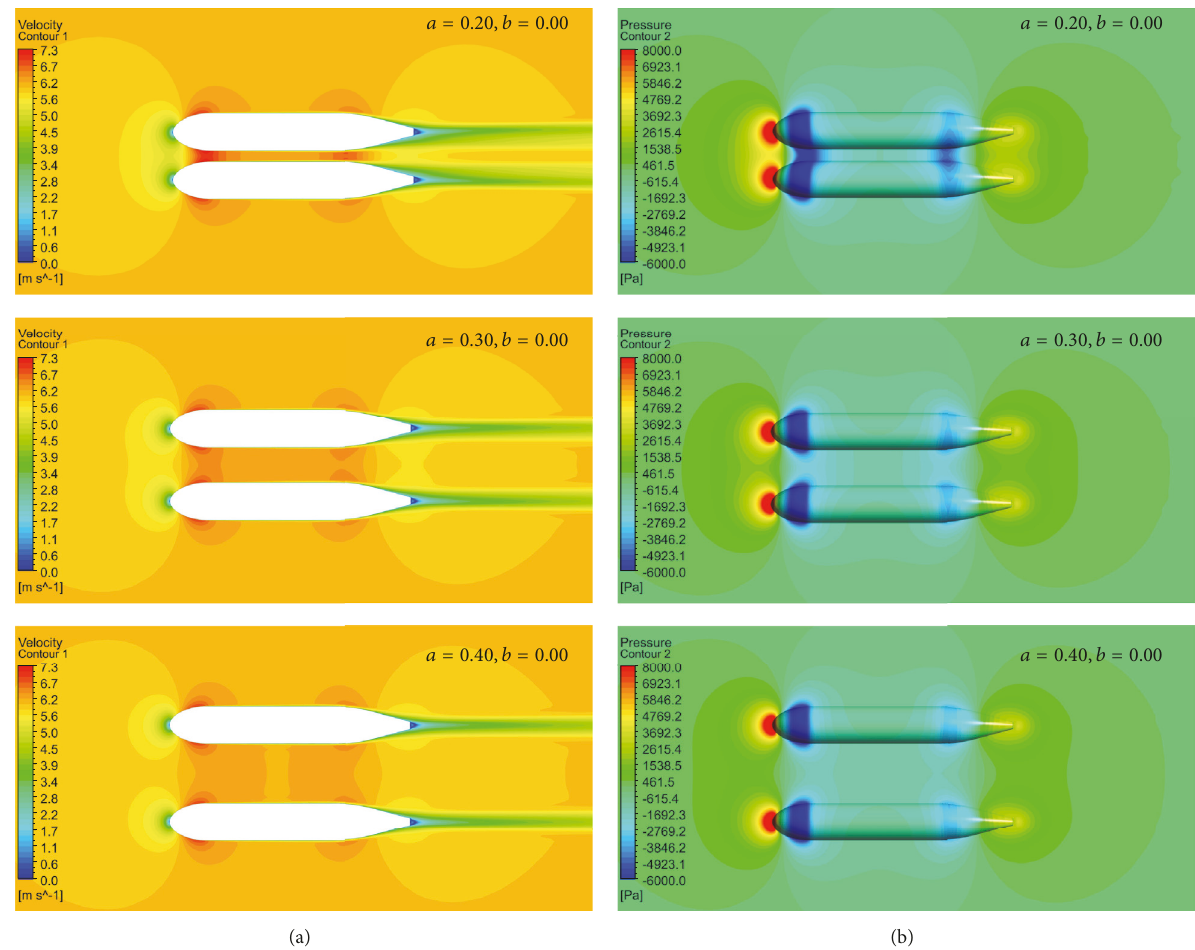
Figure 11: Contours of (a) velocity and (b) pressure around two parallel AUVs at different latitudinal offsets.